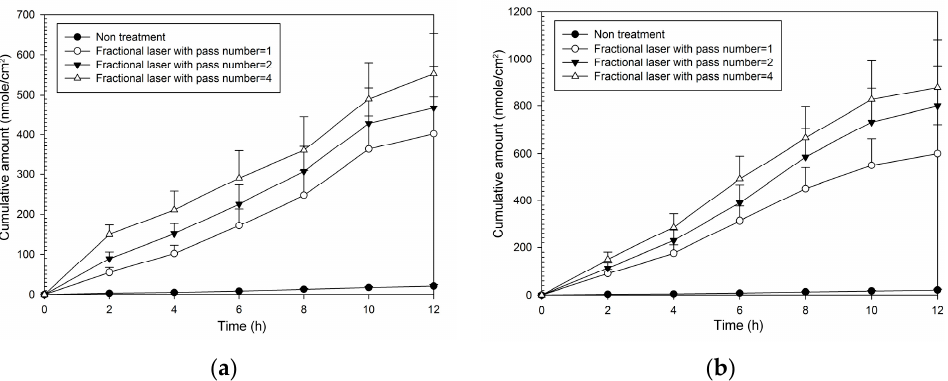
Figure 4. Cumulative amount of time profiles of in vitro transdermal permeation through porcine skin of MAP-2, after fractional CO 2 laser pre-treatment with a 12 mm spot size and different pass number at ( a ) 5 W and ( b ) 9 W fluence.